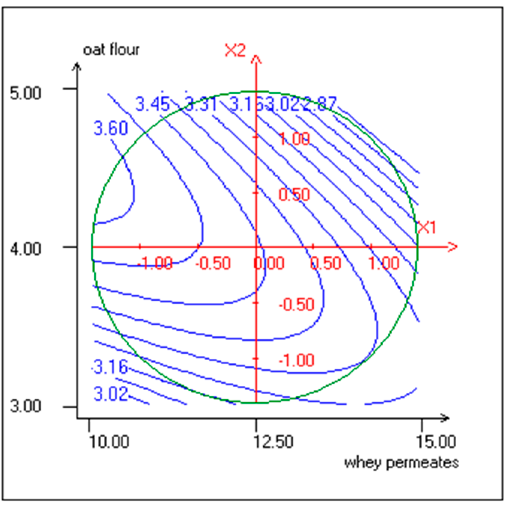
Figure 4. Response surface and contour plots representing the effect of WP and OF on overall acceptability (X1: WP; X2: OF).